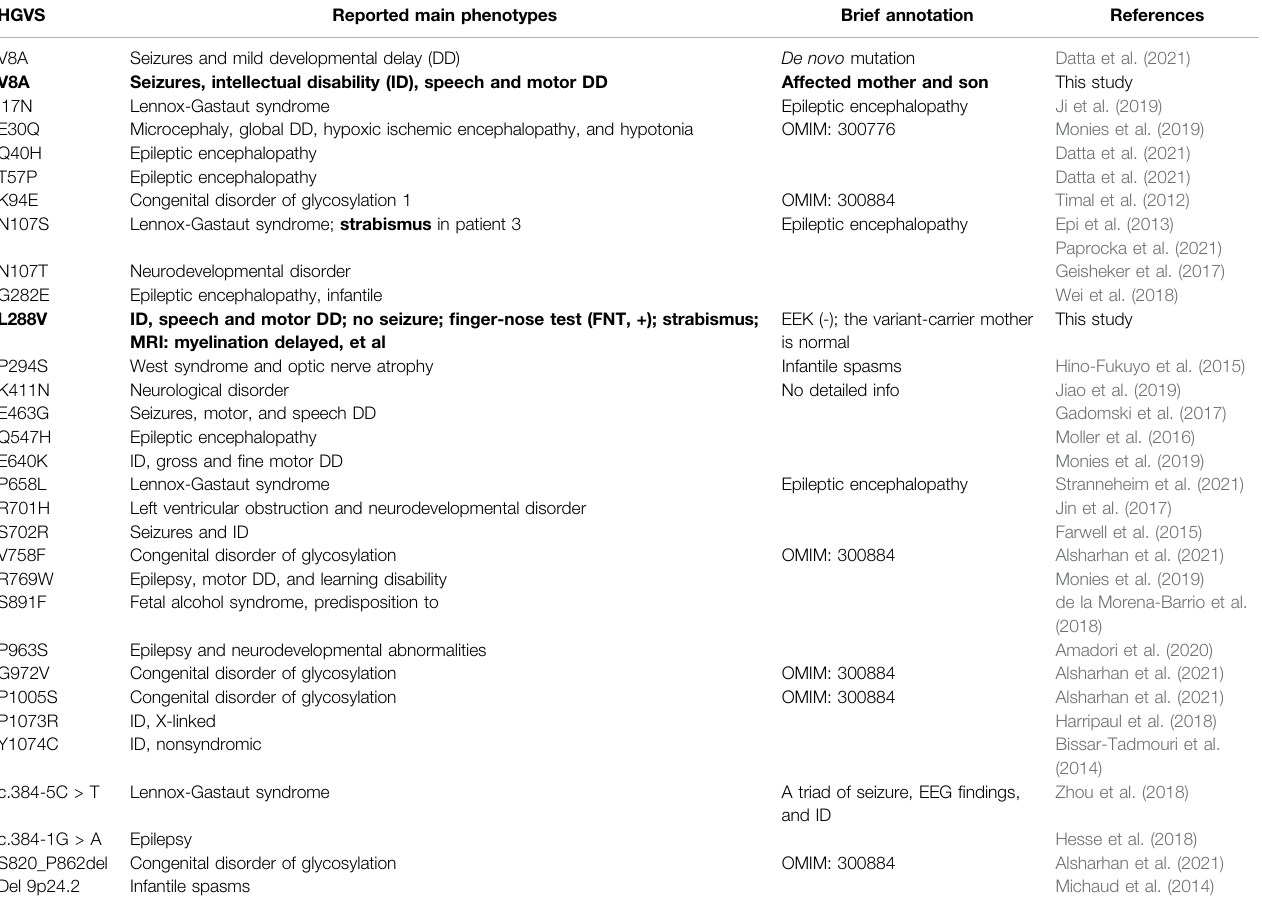
TABLE 1 | Genotype – phenotype correlation analyses for affected individuals with ALG13 variants. The bold presents the phenotype in this study or a special phenotype related to this